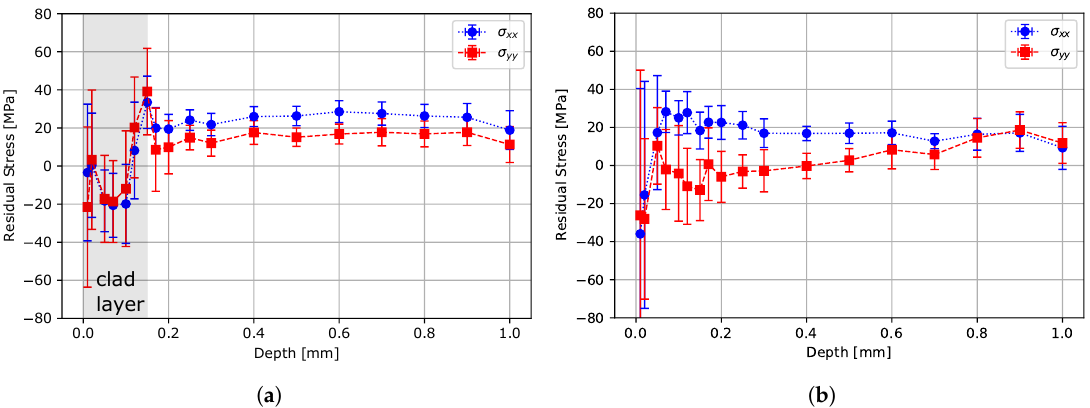
Figure 2. The residual stress profile of unpeened materials: ( a ) AA2024-T3clad, the gray area indicates the clad layer; ( b ) AA2024-T3